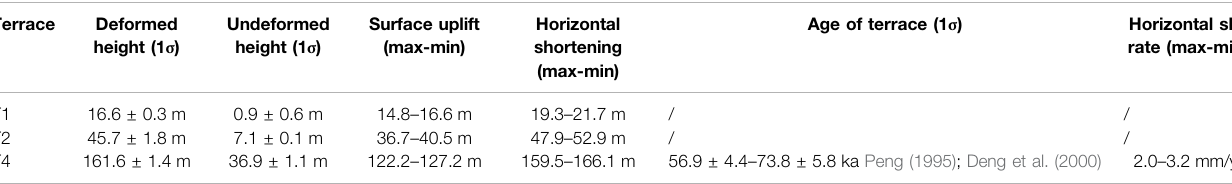
TABLE 1 | Terrace deformation and kinematic model inputs and results.